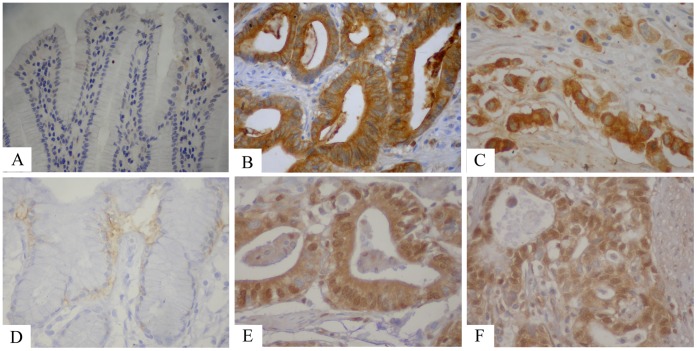
Immunohistochemical staining for TMPRSS4 and Erk1 in gastric cancer lesions and noncancerous tissues.
A TMPRSS4 negative in noncancerous tissues, magnification×400. B TMPRSS4 was highly expressed in moderately differentiated adenocarcinoma, magnification×400. C TMPRSS4 was highly expressed in poorly differentiated adenocarcinoma, magnification×400, respectively. D Erk1 negative in noncancerous tissues, magnification×400. E Erk1 was highly expressed in moderately differentiated adenocarcinoma, magnification×400. F Erk1 was highly expressed in poorly differentiated adenocarcinoma, magnification×400.